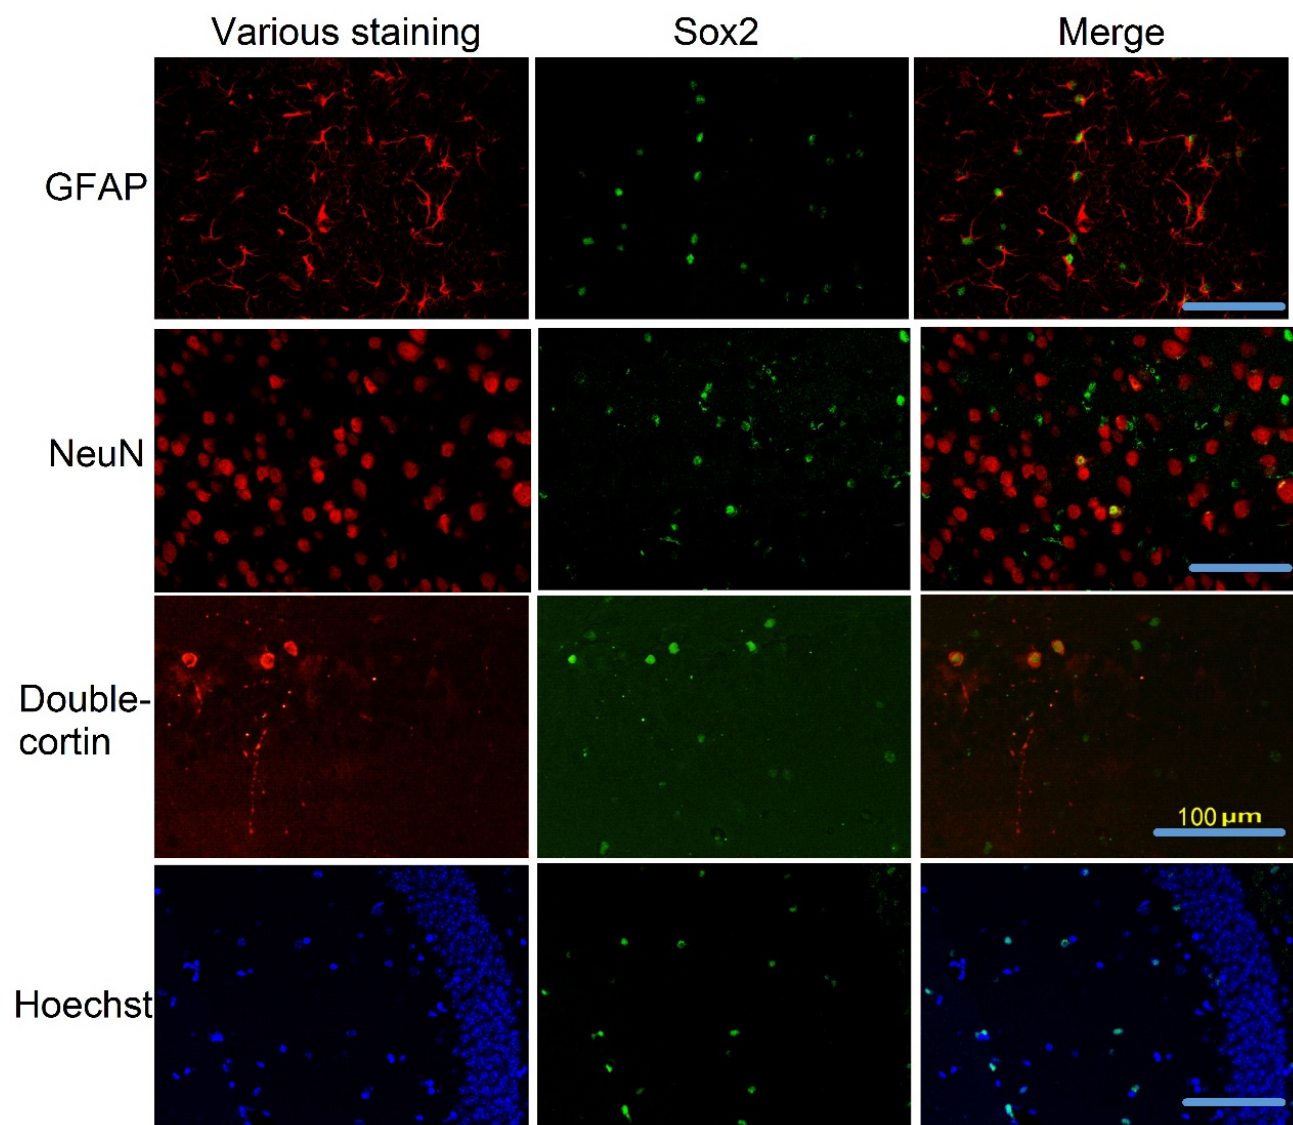
Figure 3. Representative images of co-staining of Sox2 with various proteins in the hippocampal dentate gyrus of control mice. Scale bar: 100 μ m.